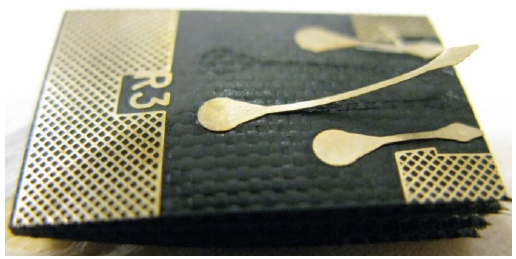
Figure 10. Detachment of the measurement wires in the corroded FR ‐ 4.